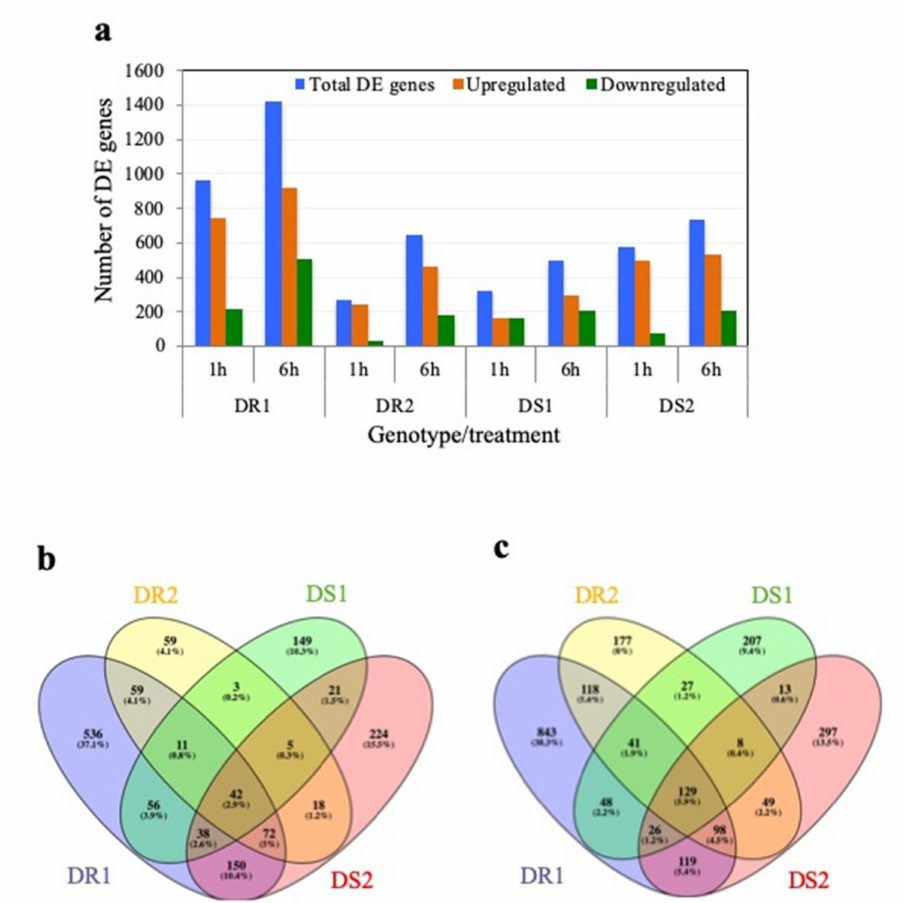
Figure 3. Di ff erentially expressed (DE) genes in di ff erent genotypes in response to drought. ( a ) Total number of DE, up- and down-regulated genes that passed the cut-o ff Log 2 FC > 2 and q-value < 0.05 as compared to control condition. ( b , c ) Venn diagrams showing the unique and common DE genes among genotypes at 1 h ( b ) and 6 h ( c